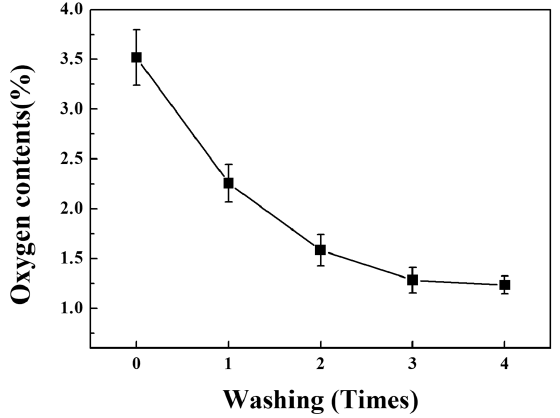
Figure 3. Oxygen contents of ZrB 2 particles via methanol treatment.